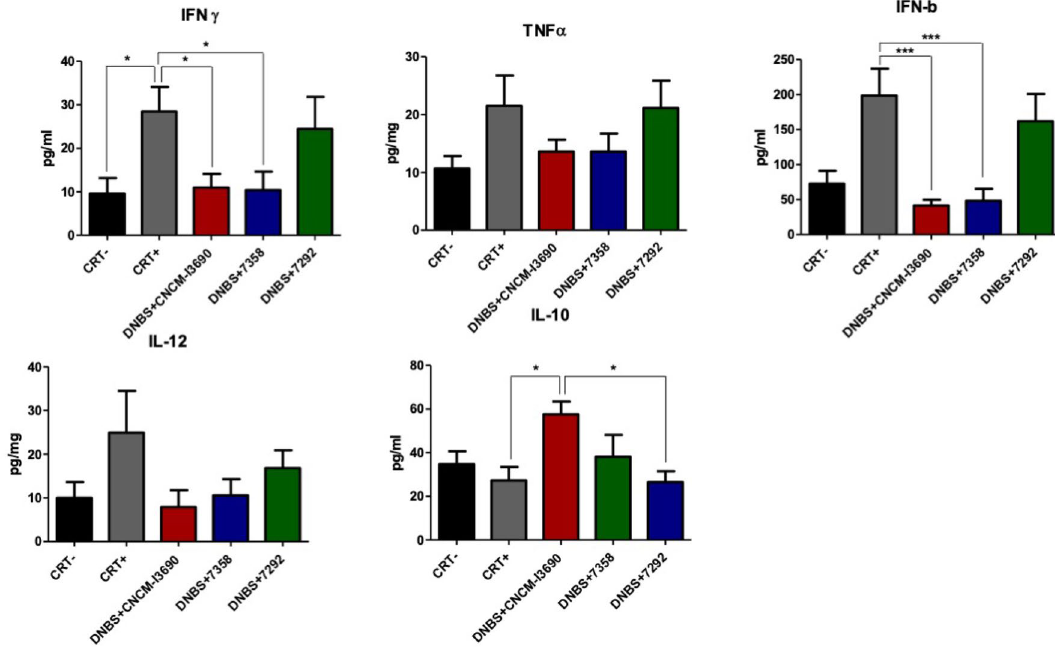
Figure 6. Colonic interleukin levels in a low grade dinitro-benzene sulfonic acid (DNBS) colitis model after treatment with the the EPS variants 7292 and 7358 in comparation with the wild-type L. rhamnosus CNCM I-3690. Significance: * p < 0.05.